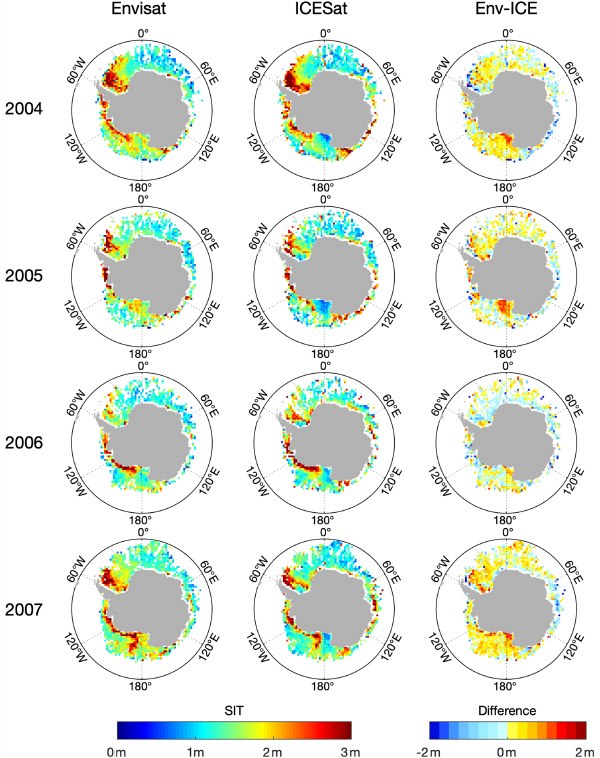
Figure 4. Comparisons of Envisat versus ICESat sea ice thickness for each ICESat operating period in spring (October and Novem- ber). The first and second columns show the sea ice thickness dis- tribution of Envisat and ICESat, respectively, and the last column shows the difference field (Envisat minus ICESat) of sea ice thick- ness. Each row represents a year from 2004 to 2007. The maps are all interpolated onto the polar-stereographic grid of the ICE- Sat product and only show grid cells where both data sets have valid SIT. The white cells denote sea ice concentration less than the threshold or missing data.